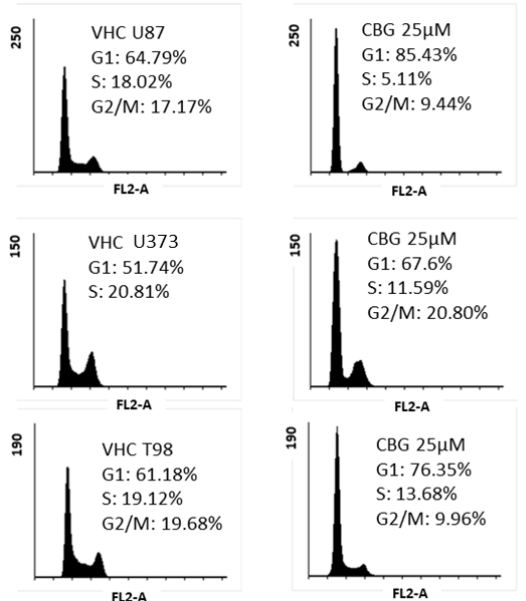
Figure 2. CBG-induced cell-cycle arrest in the G1 phase in GB cell lines. The cell lines U87, U373, and T98 were treated with 25 µ M CBG twice within 48 h. The representative cell cycle distribution was analysed by flow cytometry, as described in the Materials and Methods sections (Section 2.9). The upper panel represents the shift in cell-cycle phase distribution (y axis: percentage of cells) vs. vehicle (left panels, comprising 0.24% ( v / v ) ethanol) after CBG treatments of U87 cells (upper panel), U373 cells (middle panel), and T98 cells (lower panel). Accumulation of cells in the G1 phase, reducing the percentage of cells in S phase and G2/M phase, was observed in all three established GB cell lines.